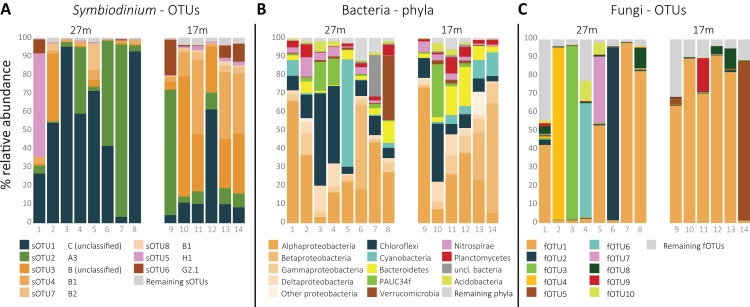
Relative distribution per sample of (A) the eight most abundant Symbiodinium OTUs, ordered by clade level classification, (B) the 10 most abundant bacterial phyla, and (C) the 10 most abundant fungal OTUs per sample.